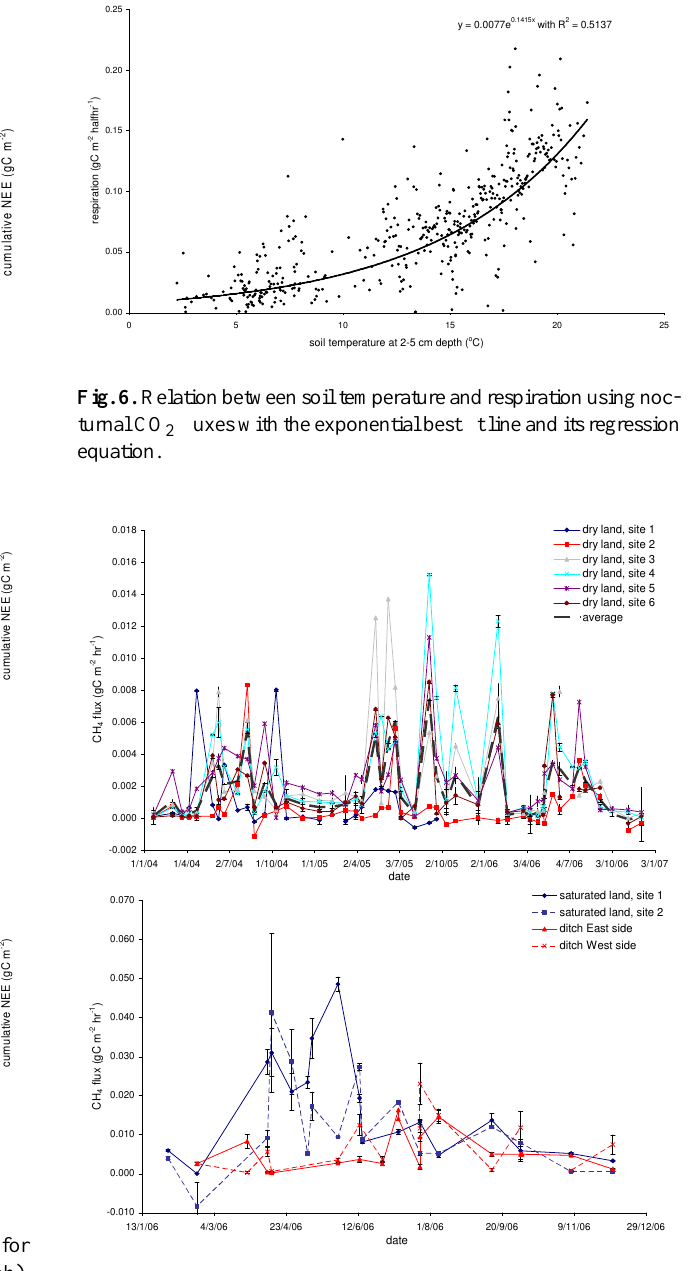
Fig. 7. Measured CH 4 fluxes at the Horstermeer site over the period 2004 to 2006 for the relatively dry land (above) and over 2006 for the saturated land and the ditches